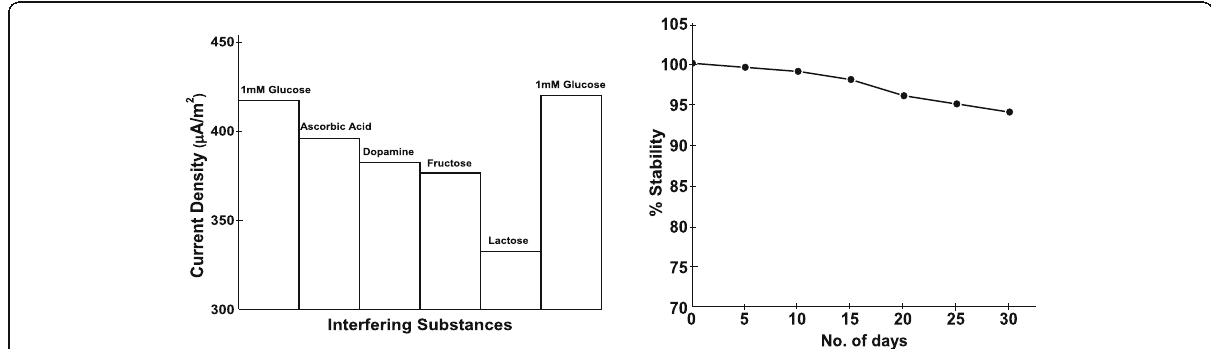
Fig. 12 a Selectivity and b stability of GO/CuO/FTO glucose